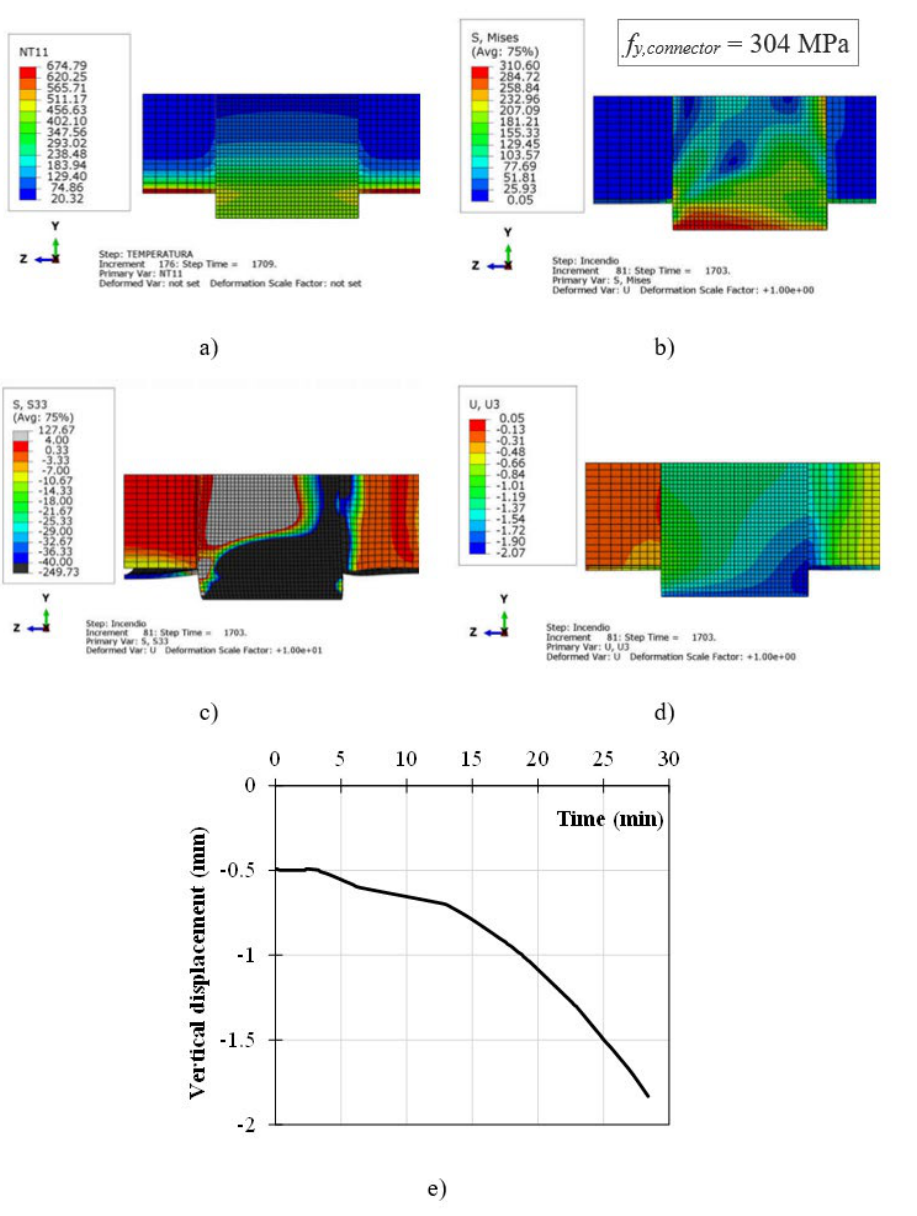
Figure 12. a) Temperature distribution, b) von Mises stresses, c) concrete tensile stresses, d) deformed configuration and e) displacement of the central point of the external surface of the connector of 400 mm diameter CFCCs with Shear Flat for the loading level of